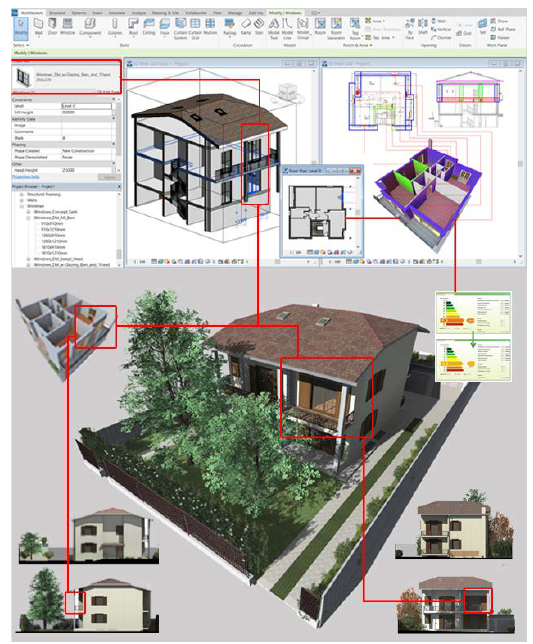
Figure 2. As-built BIM of a (simplified) building obtained with the parametric modelling logic of BIM software.